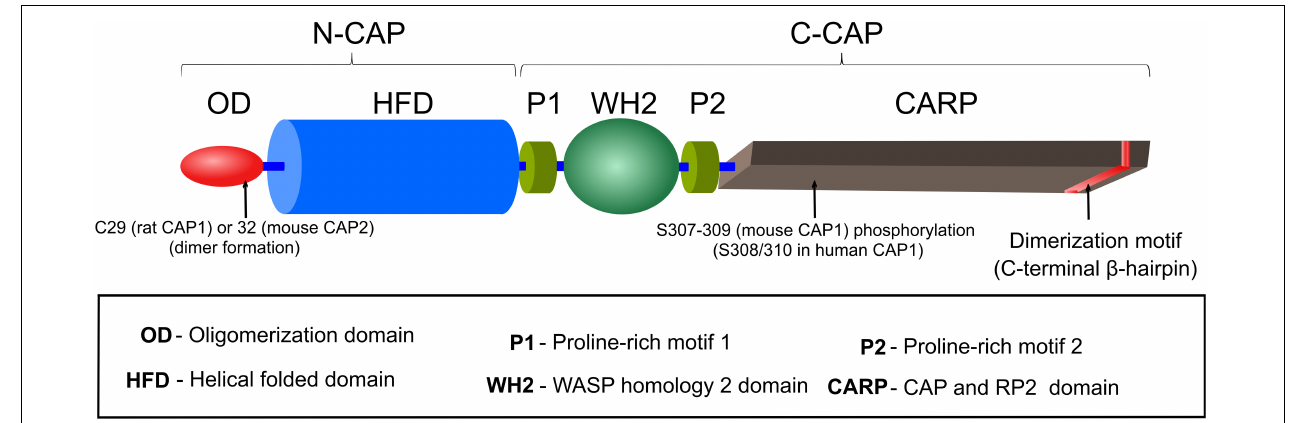
FIGURE 1 | Domain organization of CAP. A detailed description of CAP’s motifs and domains is provided in the section ‘Structure and domain organization’.